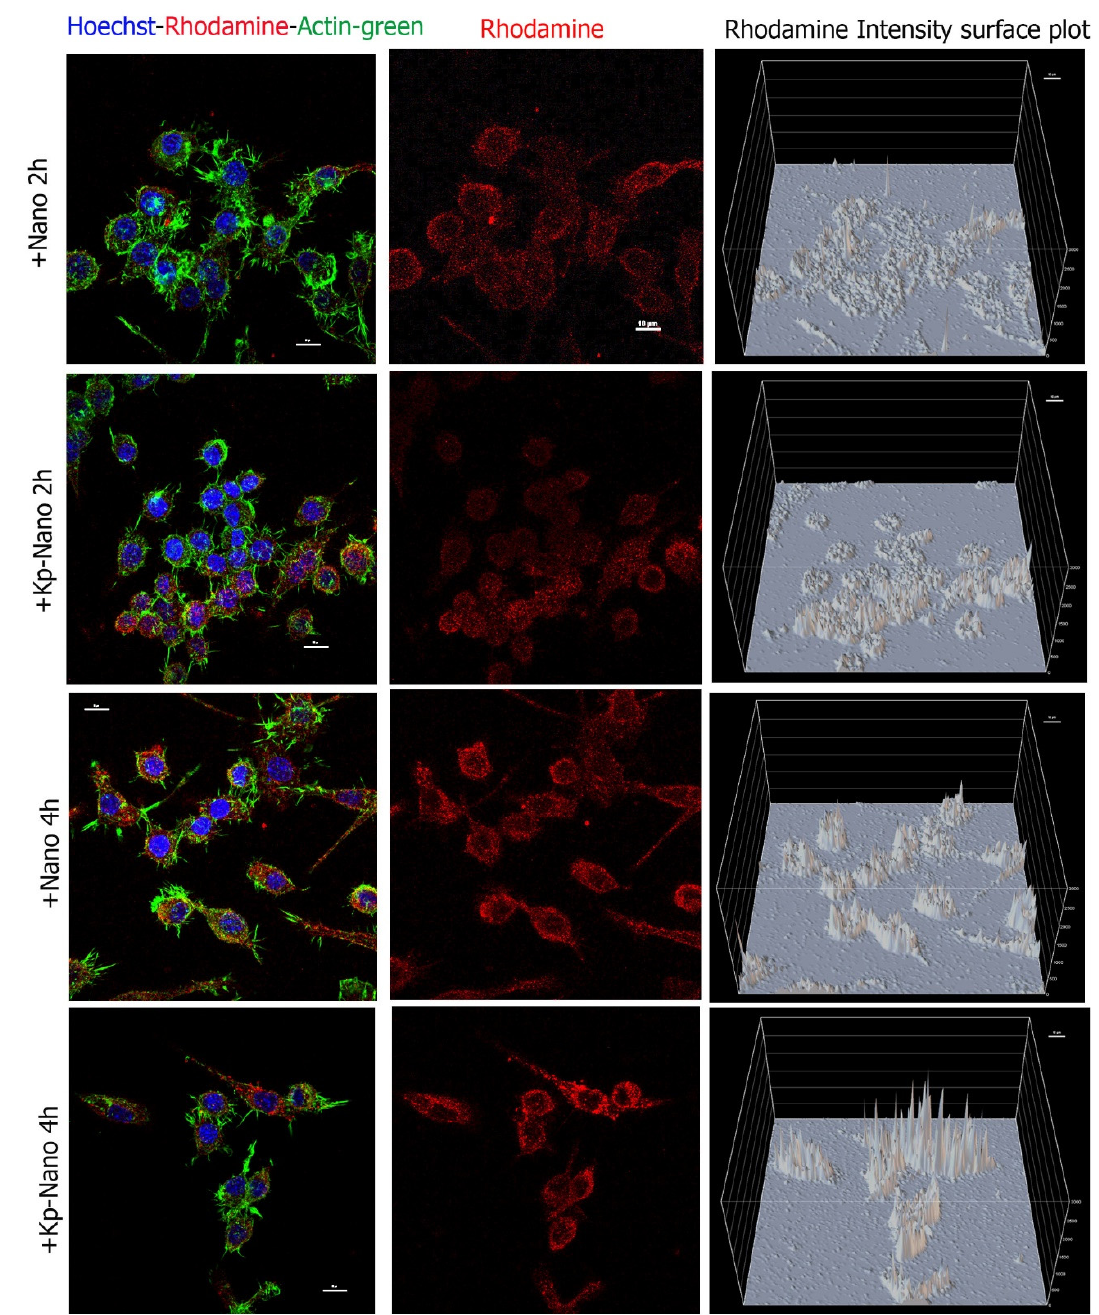
Figure 5. Cellular internalization. Confocal analyses of RAW264.7 cells treated for 2 h and 4 h with Nano or KP-Nano (both in red) and stained with ActinGreen™ 488 for the cytoskeleton (in green) and with Hoechst 33342 (in blue) for the nuclei. The left and middle panels show the maximum intensity projection of five focal planes, with the merge of the three signals on the left and only the rhodamine in the center. The scale bar is 10 µ m. The right panels show the intensity of rhodamine fluorescence for pixel; in the graphs, the fluorescence intensity is reported as an arbitrary unit of fluorescence (auf) and the scale of the grid is 500 auf.